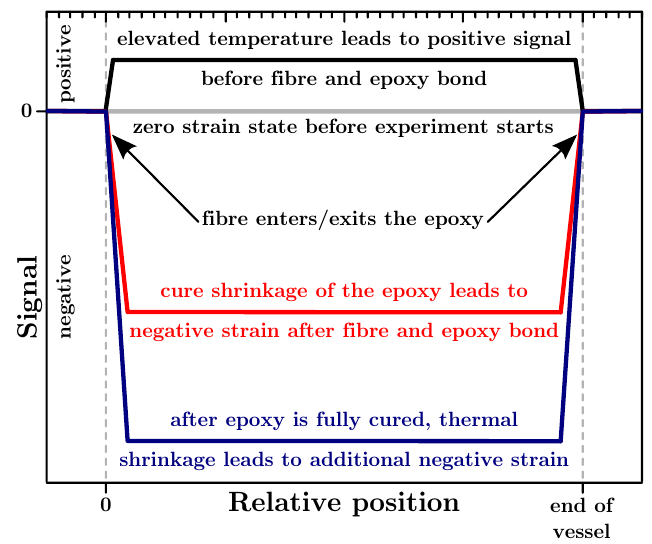
Figure 3. A general sketch of the anticipated strain behavior of hardening epoxy. A positive signal due to elevated temperatures is not to be interpreted as actual